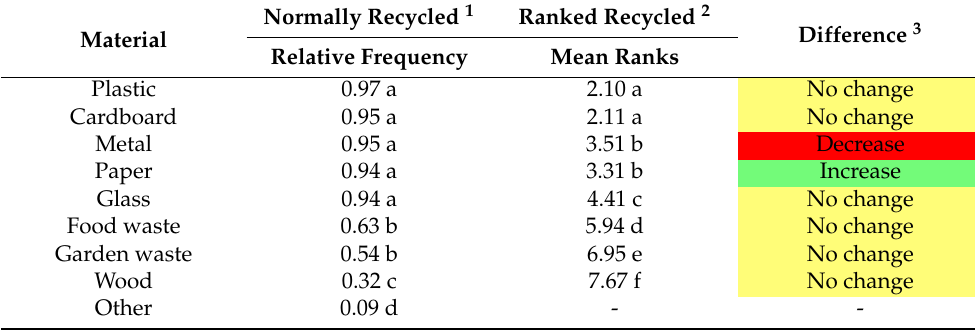
Table 3. Consumers ( n = 405) normally recycled materials and ranked order.